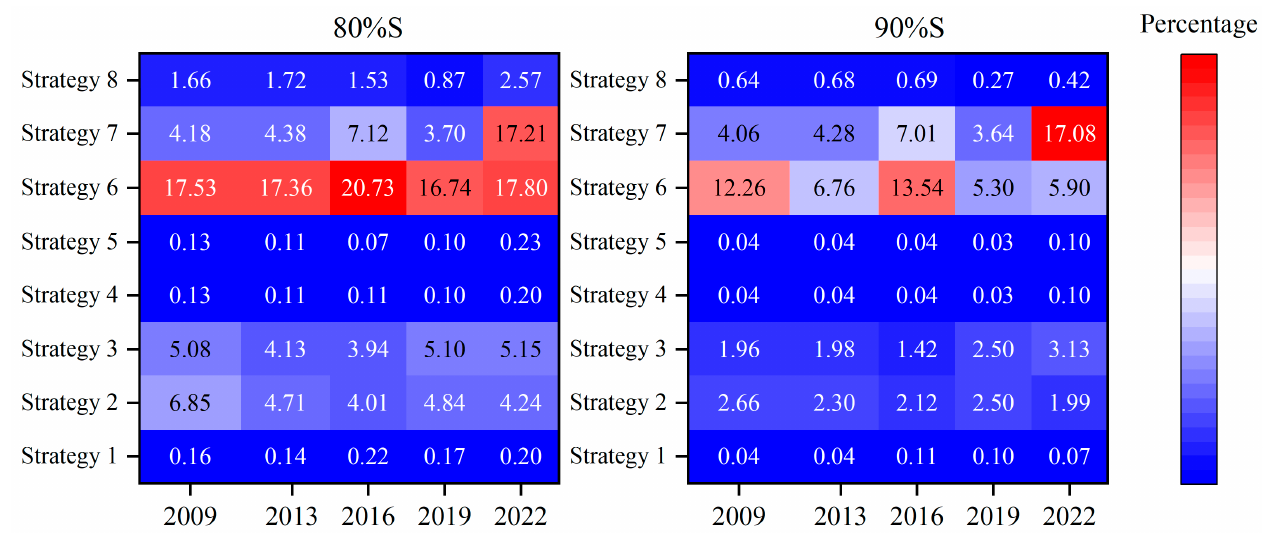
Figure 6. The relationship between the network accessibility of the rail network and the failure ratio of each disturbance strategy.